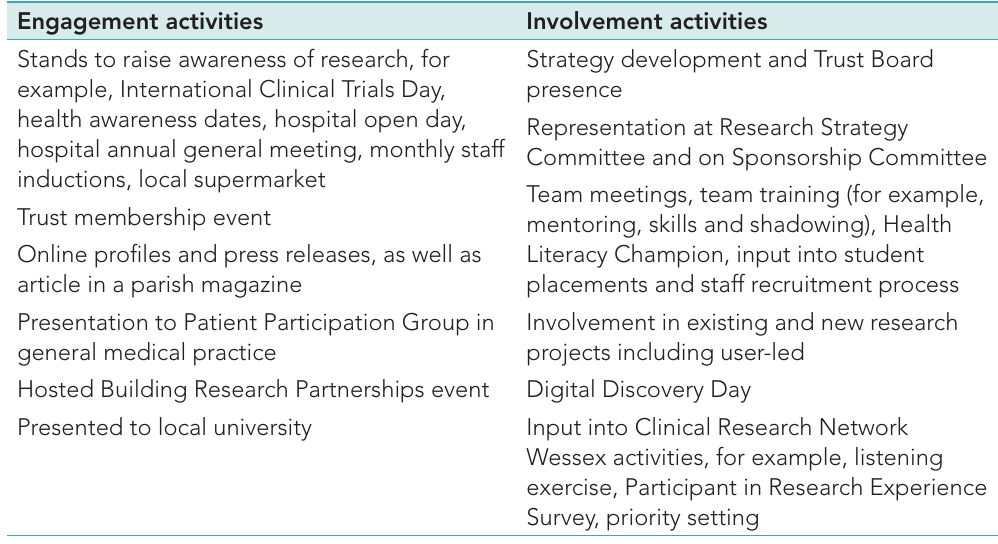
Table 1: summary of engagement and involvement activities by research